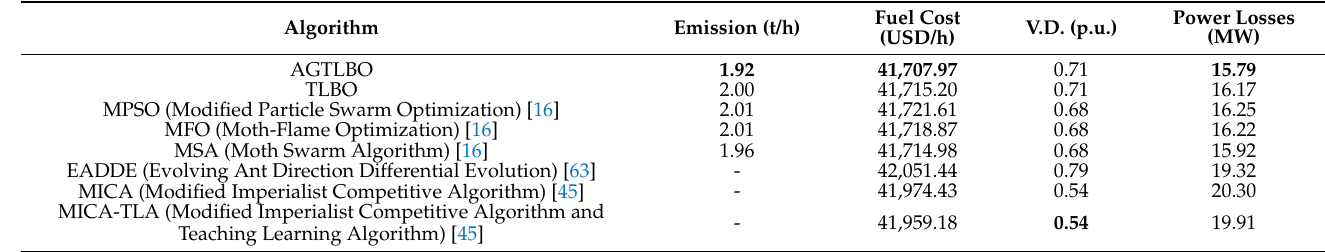
Table 12. Optimal results by different algorithms for Case